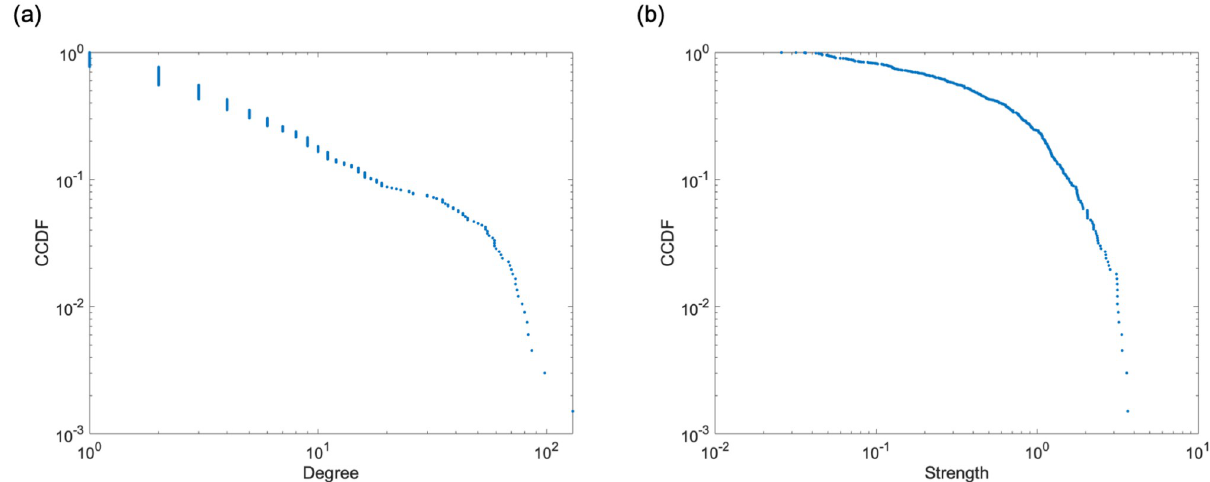
Fig 4. Empirical complementary cumulative distribution functions (CCDF) of degree and strength. (a) Degree and (b) strength. Both are widely distributed. These figures show that the number of medical providers with which patients are shared and the level of medical cooperation with neighboring medical providers vary greatly among medical providers.